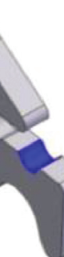
Figure 7: Metal block model.